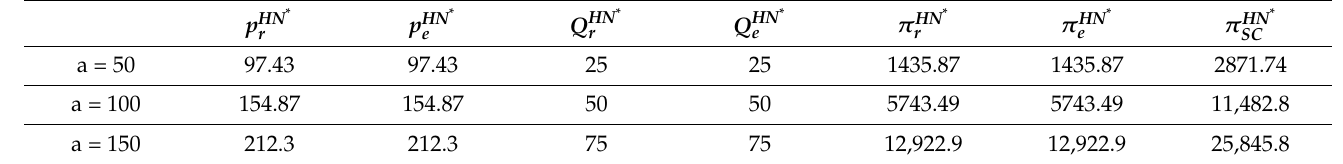
Table 1. Optimal decisions of channel members under the HN game—Case